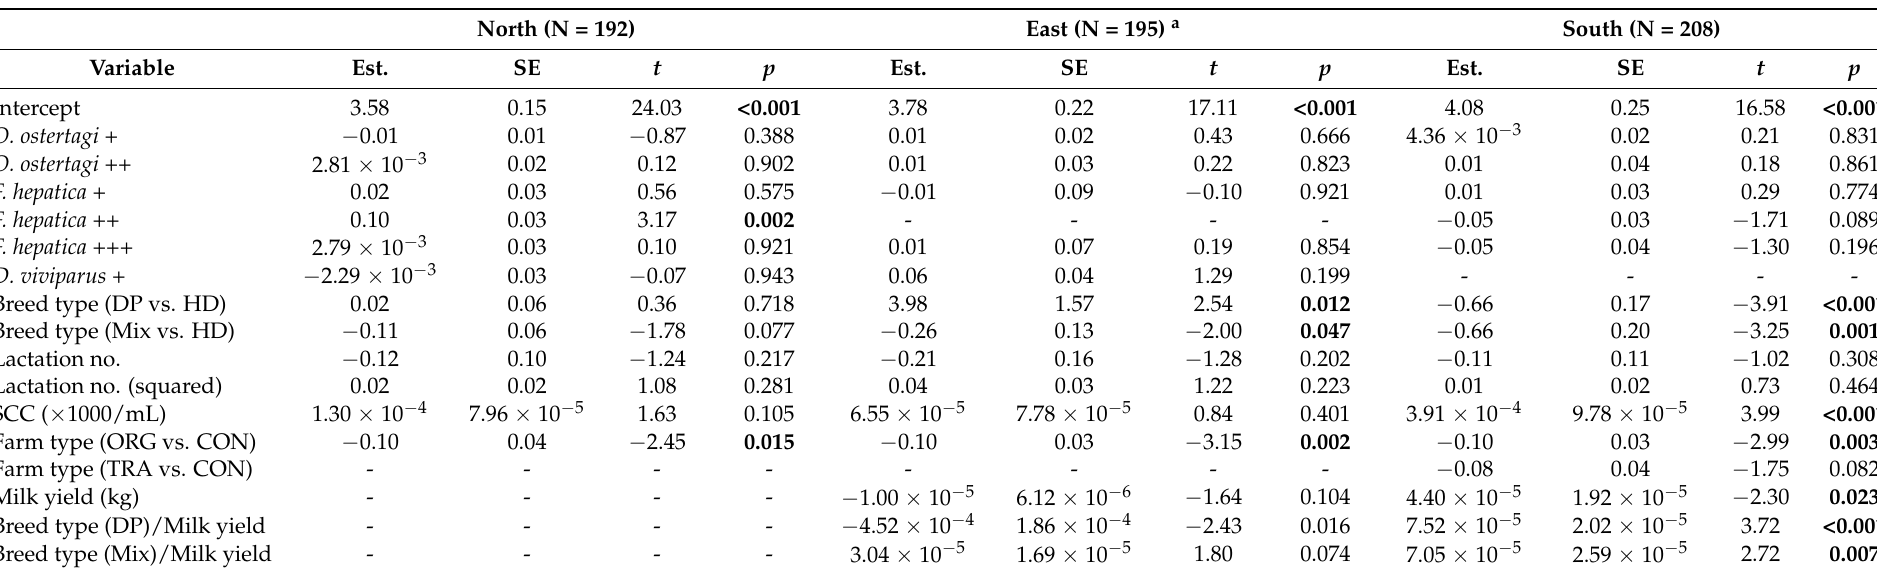
Table 7. Results from linear models investigating the association of O. ostertagi , F. hepatica and D. viviparus BTM ELISA results and average milk protein content (%) in three regions of Germany. Full models were significantly different from null models containing only an intercept term (North: Df = 12, F = 2.3, p = 0.009; East: Df = 14, F = 2.7, p = 0.001; South: Df = 15, F = 6.0, p < 0.001). Significant p -values are printed in bold. Seropositivity categories are defined as follows: O. ostertagi : +: ODR ≥ 0.5, ++: ODR ≥ 0.8; F. hepatica : +: 30% < S/P ≤ 80%, ++: